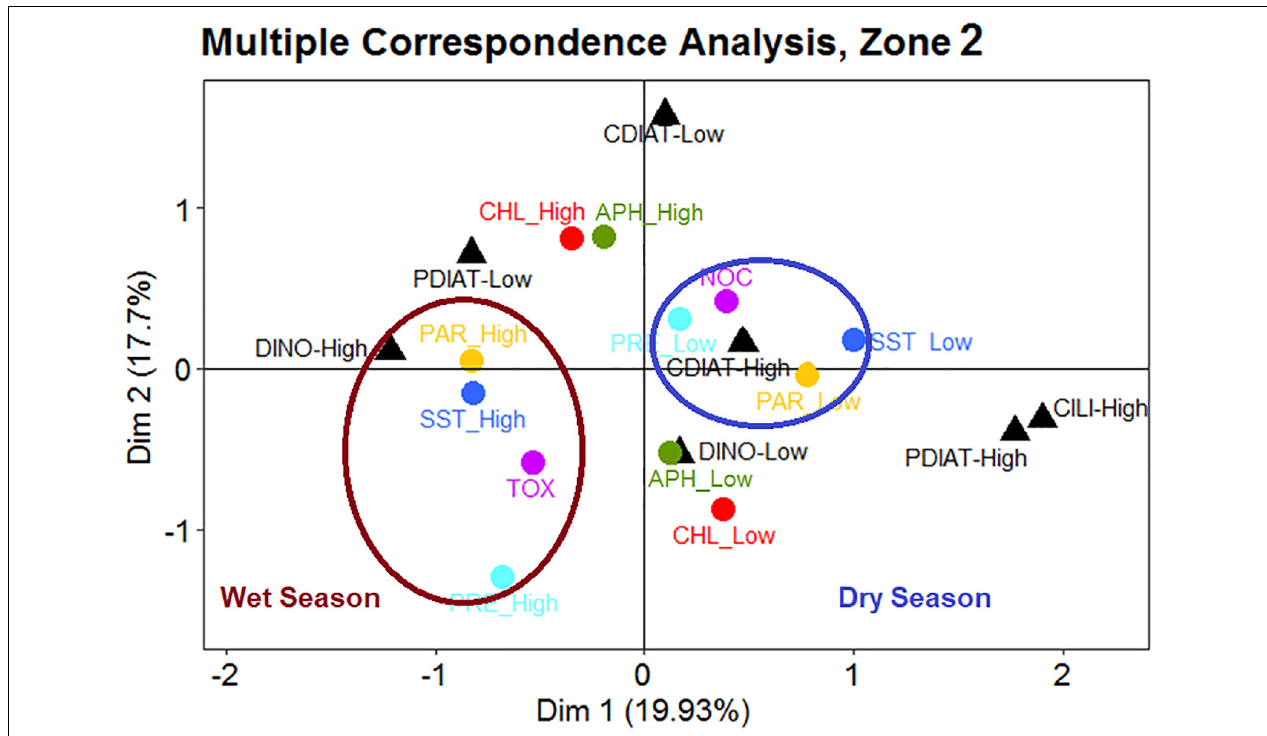
FIGURE 8 | In Zone 2, occurrences of toxic HABs (TOX) are associated with high levels of sea surface temperature (SST), photosynthetic active radiation (PAR), and precipitation (PRE), accompanied by high concentrations of dinoflagellates during the wet season. Events of non-toxic HABs (NOC) seem to be associated with low levels of SST, PRE and PAR and high levels of centric diatoms during the dry